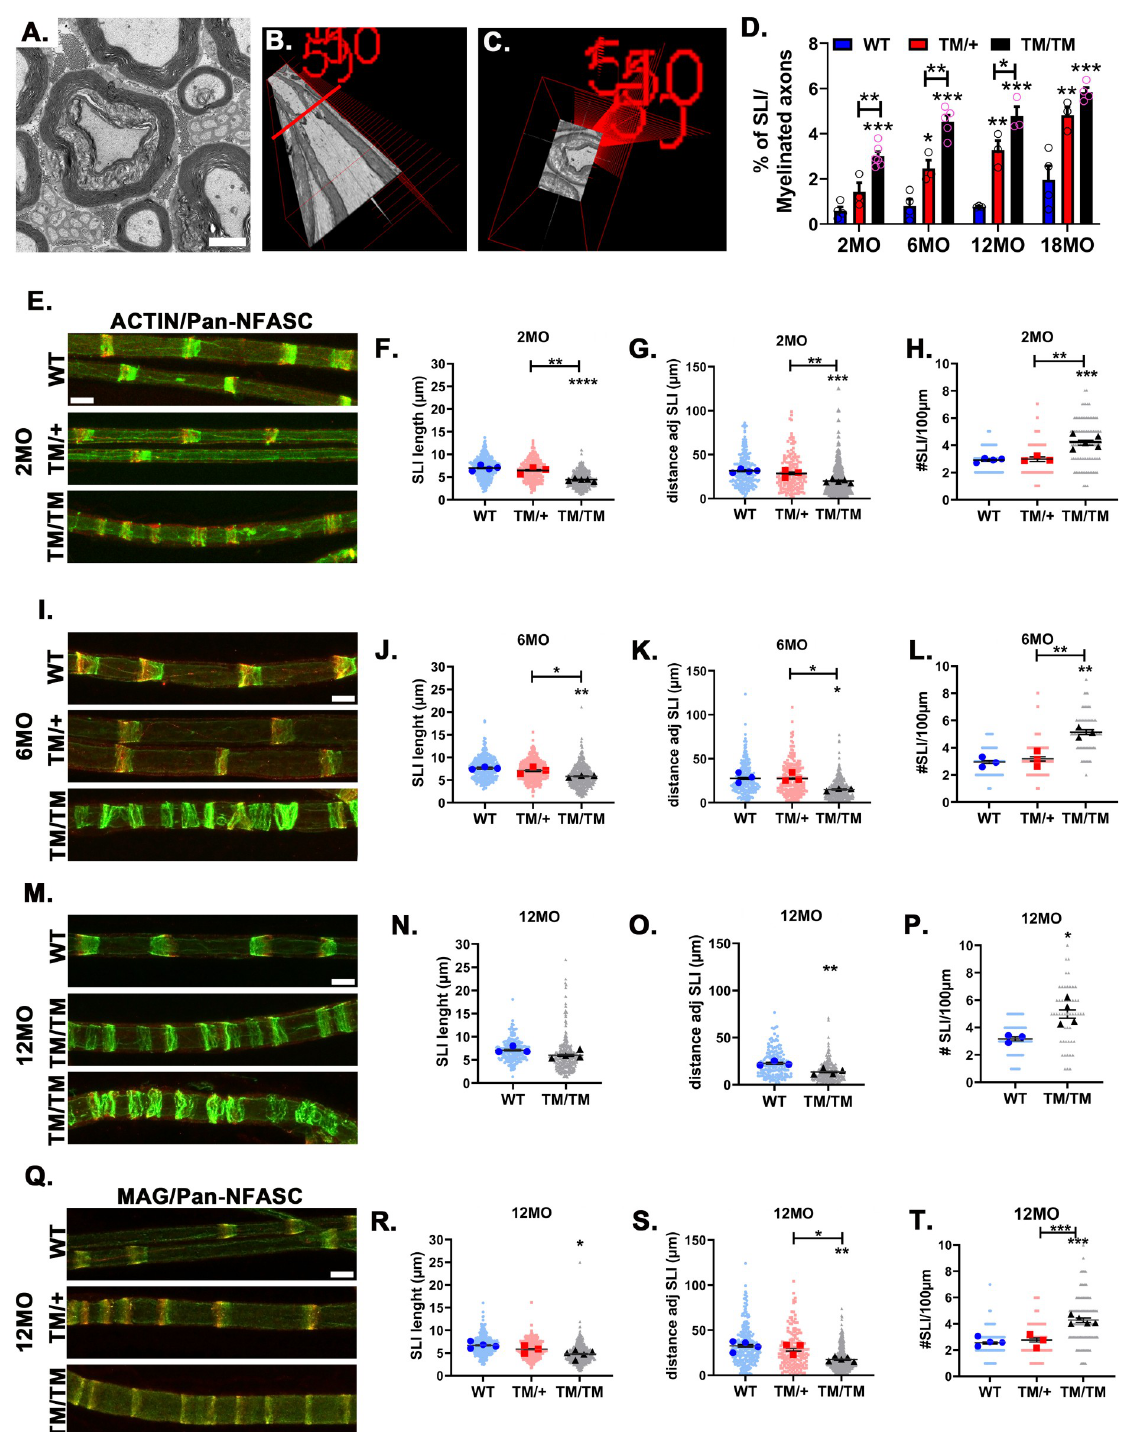
Fig 6. P0T124M mutation alters SLI morphology, length, and distribution. ( A ). Representative electron micrograph of Schmidt- Lanterman incisures (SLI) in sciatic nerve transverse section. SLI is illustrated by uncompacted myelin surrounded by two layers of compact myelin. ( B ) Three-dimensional electron micrograph showing myelinated axon with one SLI in longitudinal view. ( C ) Coronal view of the same SLI seen in B at the level of the red line. ( D ) Quantification shows an increased percentage of SLIs in nerves from mice harboring the P0T124M mutation ( Mpz T124M ) at 2, 6, 12, and 18 months of age. One-way ANOVA [2 month old: F (2, 10) = 29.86, p < 0.0001; 6 month old: F (2, 9) = 41.60, p < 0.0001, 12 month old: F (2, 6) = 34.35, p = 0.0005; 18 month old: F (2, 8) = 21.71, p = 0.0006].